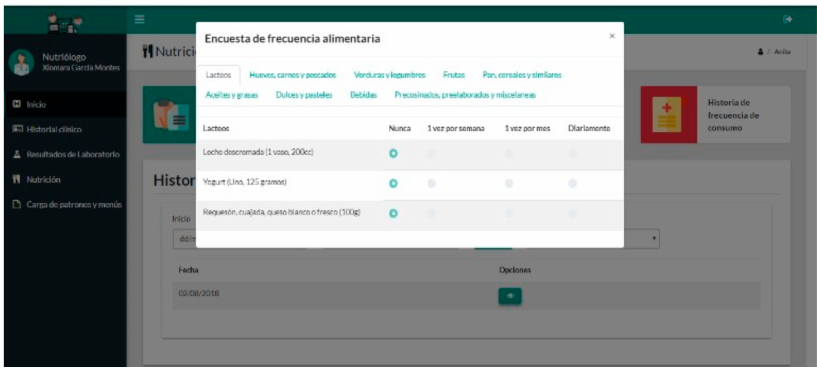
Figure 31. Nutritionist application interface: The history of intake frequency.